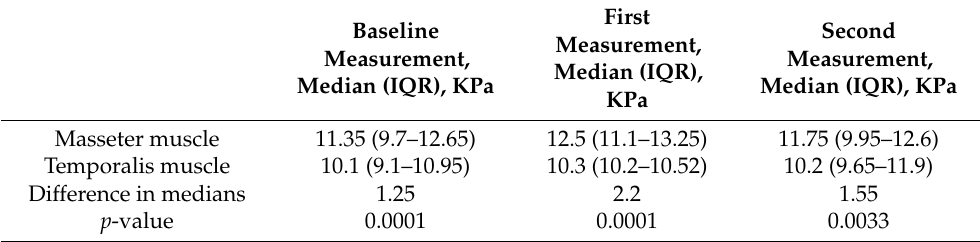
Table 2. Comparison of stiffness measurements as measured with shear wave elastography between the masseter muscle and temporalis muscle.